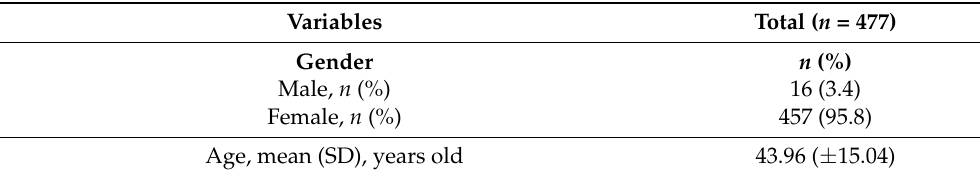
Table 1. Demographic characteristics of a subsample of Registered Dietitian Nutritionists (RDN) participants. ( n =